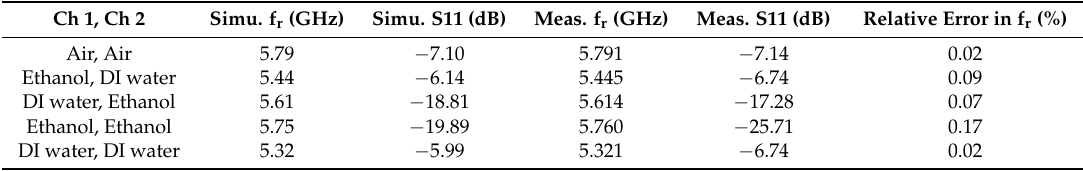
Table 3. Comparison of our TM 02 -mode QMSIW resonator with recently proposed SIW chemical sensors.